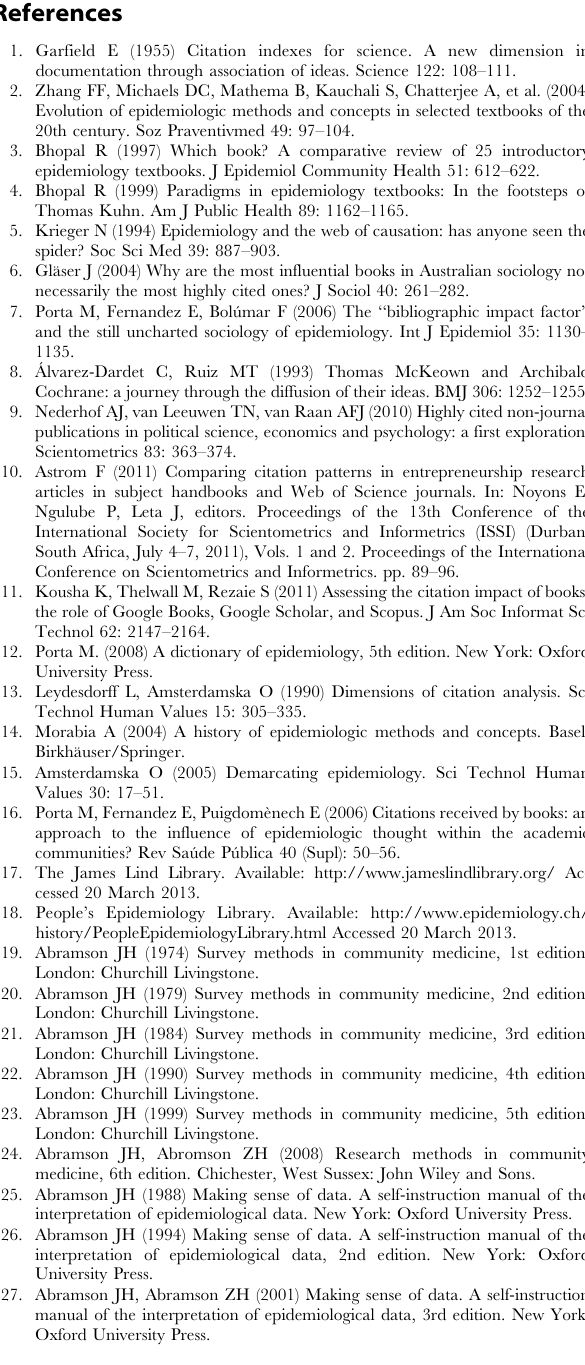
Figure S9 Citations to 2 books on occupational epide- miology: H. Checkoway et al. (619 citations) and R.R. Monson et al. (297 citations). Figure S10 Trends of citations to the book by Hosmer & Lemeshow, and to the article by Mantel & Haenszel.